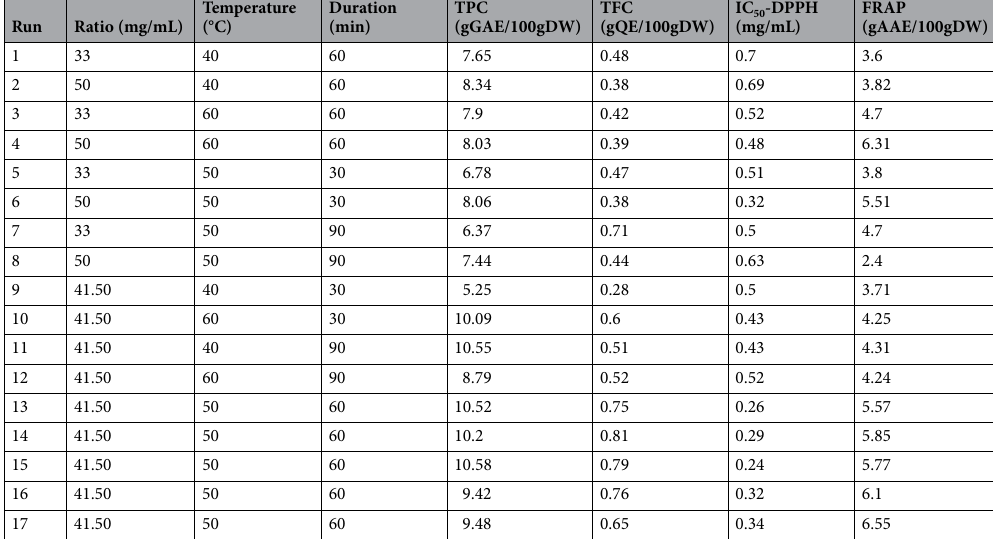
Table 2. Experimental conditions for Box–Behnken design and the corresponding results obtained for TPC, TFC, FRAP and DPPH.